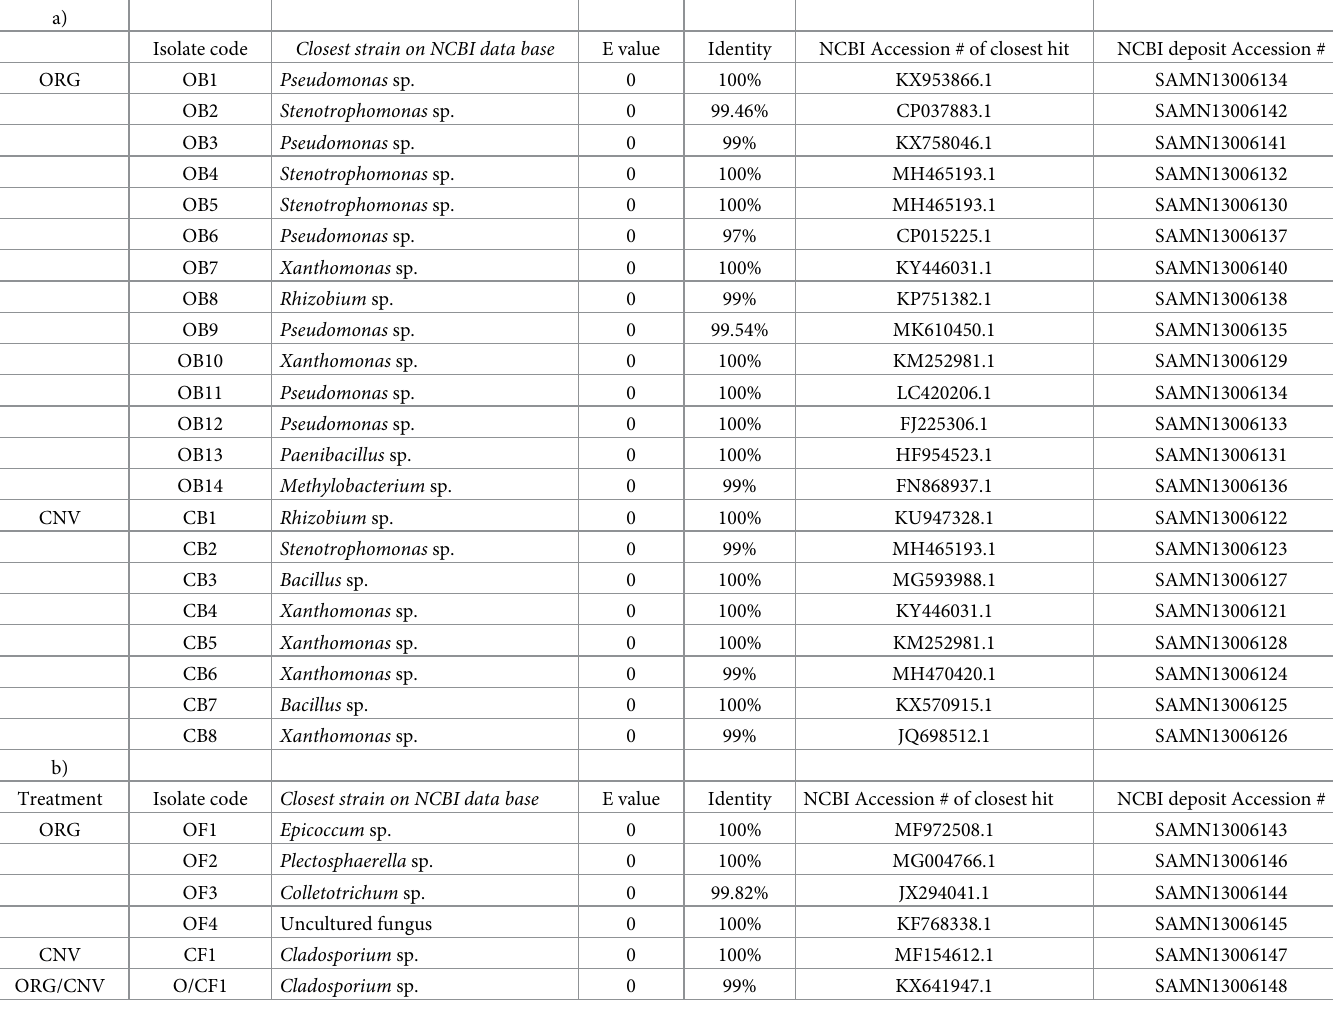
Table 4. Identification of unique endophytic bacteria (a) and fungi (b) recovered from the taproots of nine diverse carrot genotypes grown in field soil managed using organic and conventional farming practices during summer 2014 at Purdue’s Meigs Horticulture Research Farm.